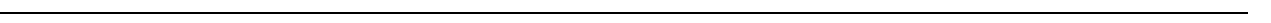
Fig. 4 Intravital image acquisition and analysis. a Images show examples of two nodules being imaged. The white arrow indicates a nodule attached to the intestine and the yellow arrow indicates a tumor mass growing into the peritoneal wall. b – e Schematic of analysis work fl ow for in vivo CEM FLIM of IGROV-1 H1-GFP labeled tumors in mouse model. Raw integrated intensity images produced by CEM at 8.5 Hz ( b ) are aligned using template matching (example template shown with green box in b ) based on normalized cross-correlation. The alignment quality is periodically degraded by breathing (example shown in c ) and frames that are severely affected by motion are rejected; the remaining frames are combined following alignment to generate high signal-to-noise image data (as shown in d ) that are suitable for FLIM analysis. The inset image with a yellow border in d shows the same 10 second acquisition but without applying the motion compensating alignment algorithm. f – h show how increasing the number of frames that are combined increases the accuracy of fi tting to a single exponential decay model. As frame accumulations are increased from 5 to 85 frames, FIFO FLIM integration times increase from sub-second to 10 s and the number of photons per pixel increases. This is associated with a decrease in the residuals following fi tting of the FLIM data to the single exponential decay model. i image segmentation was used to calculate lifetimes on a nucleus by nucleus basis: a locally adaptive thresholding routine was used to form an initial segmentation guess and then erosion and dilation steps were used to separate contiguous nuclei, followed by application of the watershed.m function in MATLAB. The segmentation masks were then loaded into FLIM fi t along with the raw TCSPC FIFO data. Integrated intensity image from aligned raw TCSPC FIFO data, watershed segmentation binary image, and FLIM fi t graphical user interface are